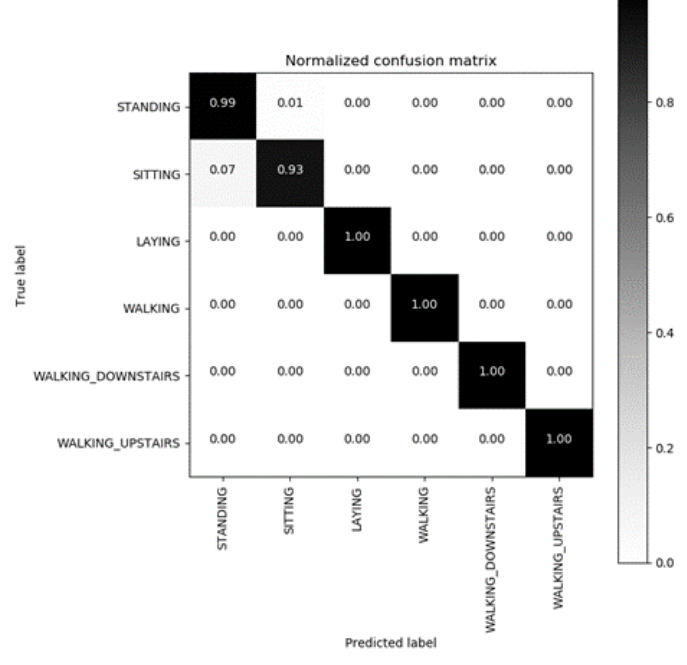
Figure 9. Confusion matrix of a support vector machine (SVM) classifier with linear kernel.